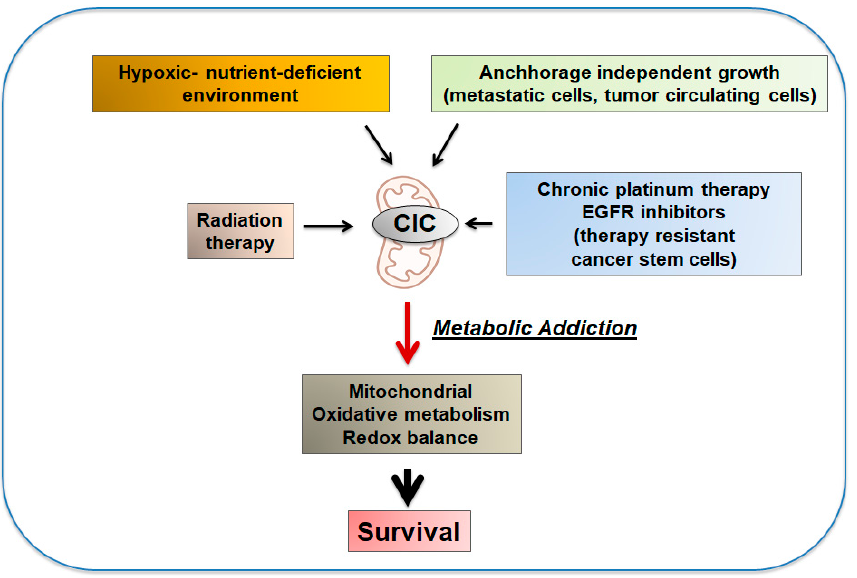
Figure 6. Involvement of CIC-dependent mitochondrial oxidative metabolism in adaptation to stress (see text for explanation). (see text for